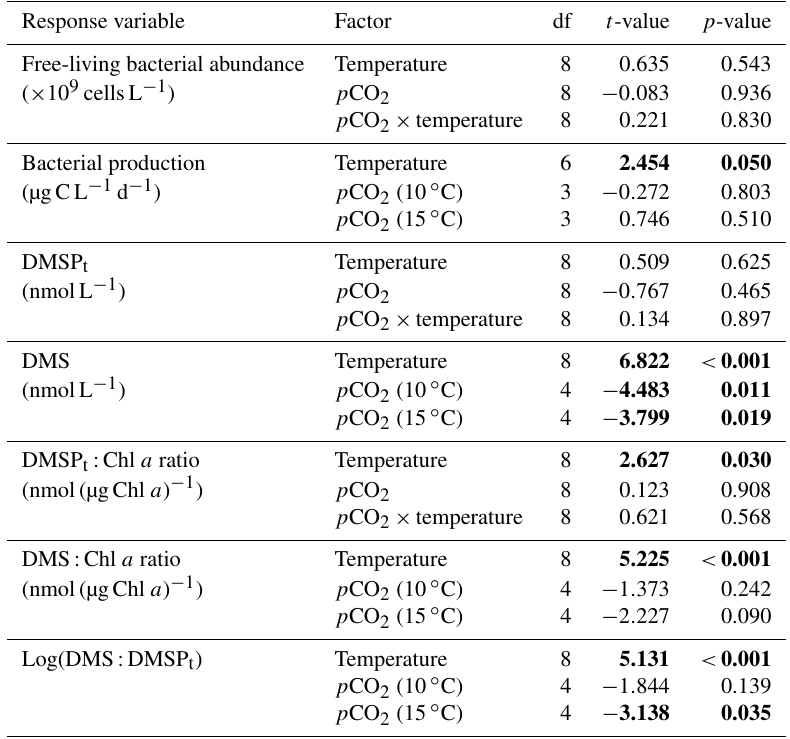
Table 1. Results of the generalized least squares models (gls) tests for the effects of temperature, p CO 2 , and their interaction over the duration of the experiment (day 0 to day 13). Separate analyses with p CO 2 as a continuous factor were performed when temperature had a significant effect. Averages of bacterial abundance and production, DMSP t , DMS, Chl a -normalized DMSP t and DMS concentrations, and DMS : DMSP t ratios are presented with corresponding degrees of freedom (df). Natural logarithm transformation is indicated when necessary. Significant results are in